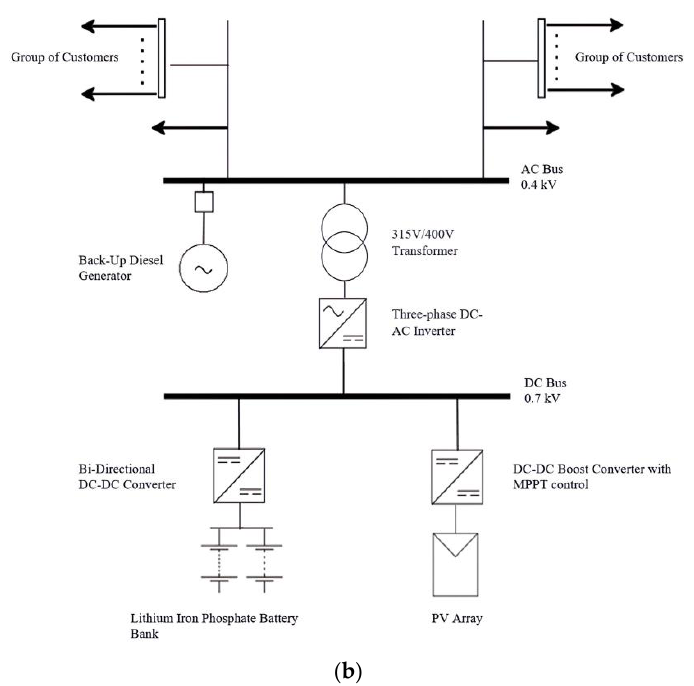
Figure 1. Mini-grid ( a ) layout; ( b ) single-line diagram (Gionseri B site in Kenya).